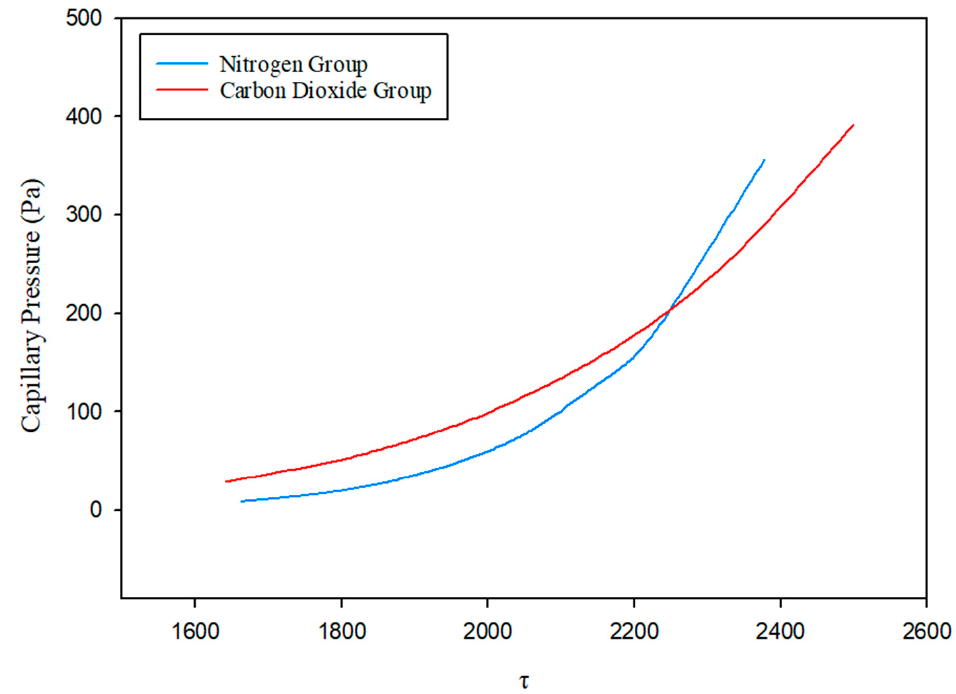
Figure 7. Capillary Pressure Comparison for Axisymmetric Pore Throat.